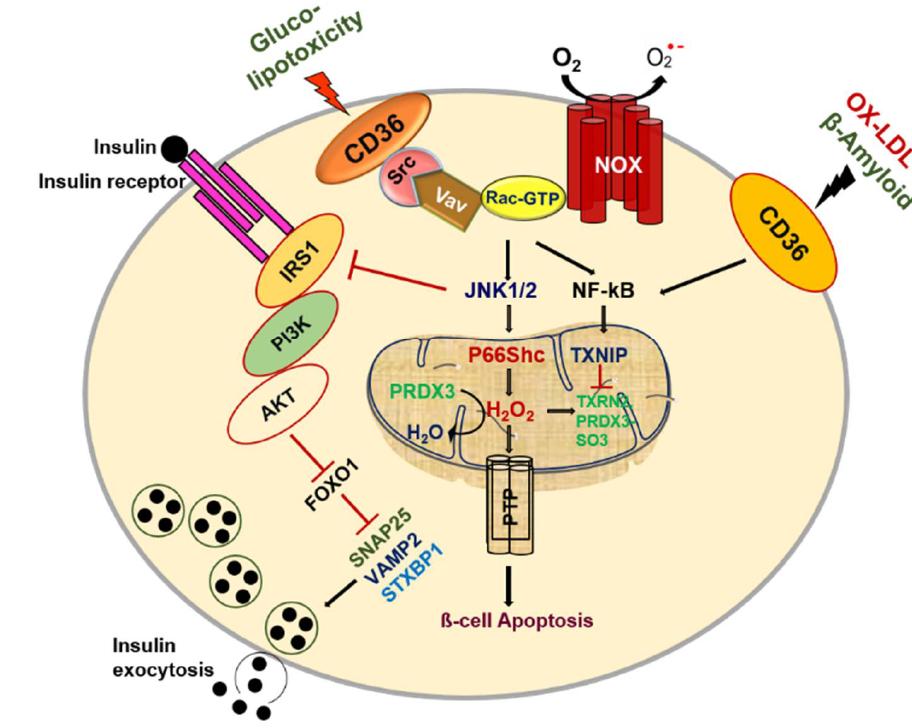
Figure 2. CD36 signal transduction in pancreatic β-cell dysfunction.